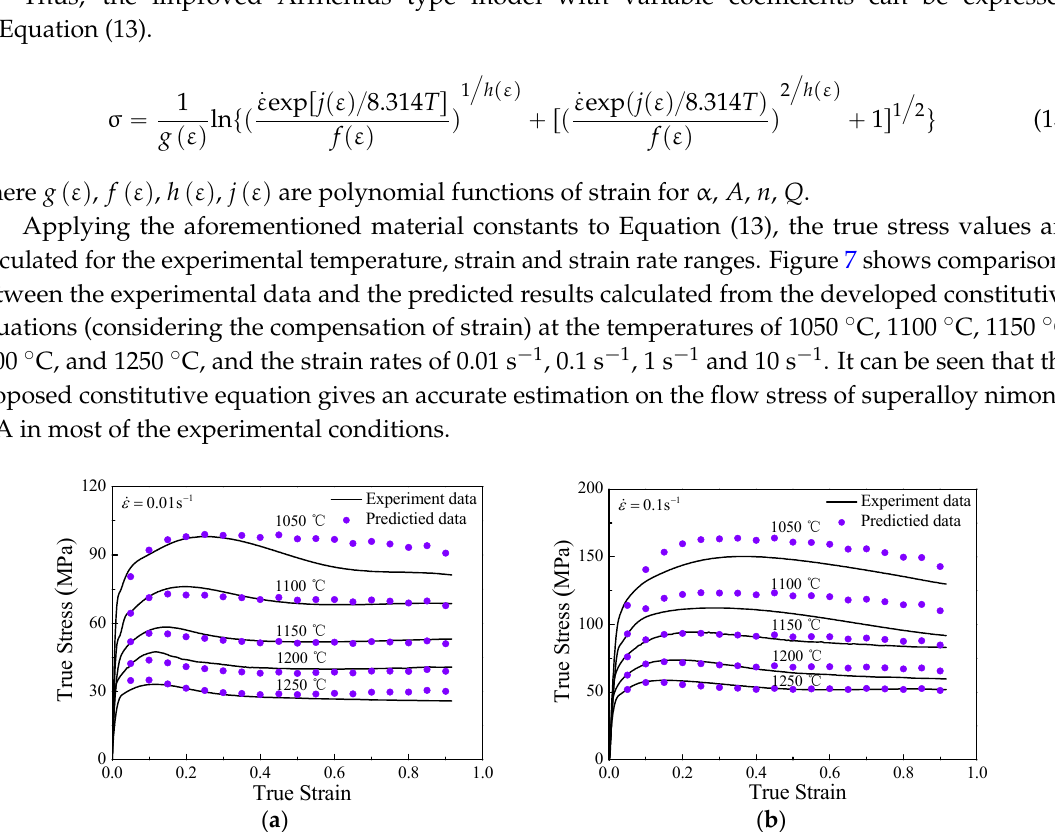
Figure 7. Cont. Figure 7. Cont.